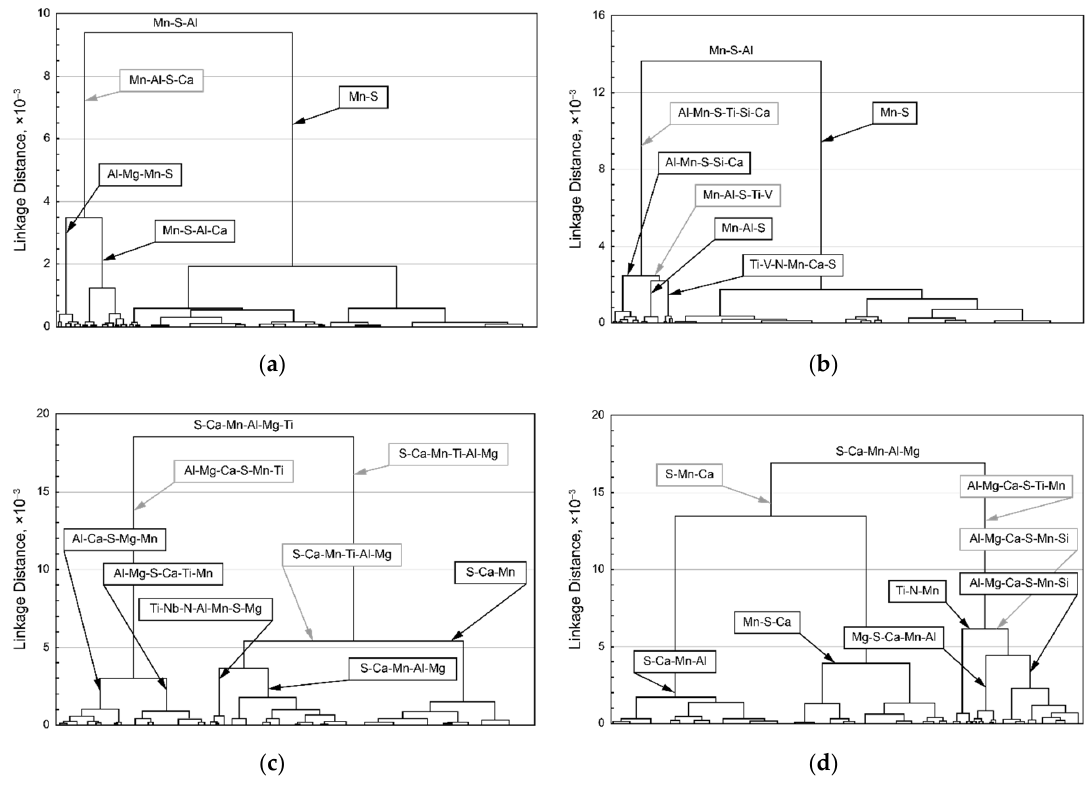
Figure 1. Dendrograms of clusters of NMIs compositions in the studied steels. ( a ) 9MnSi5; ( b ) B; ( c ) X70; ( d ) 30CrMnSi.